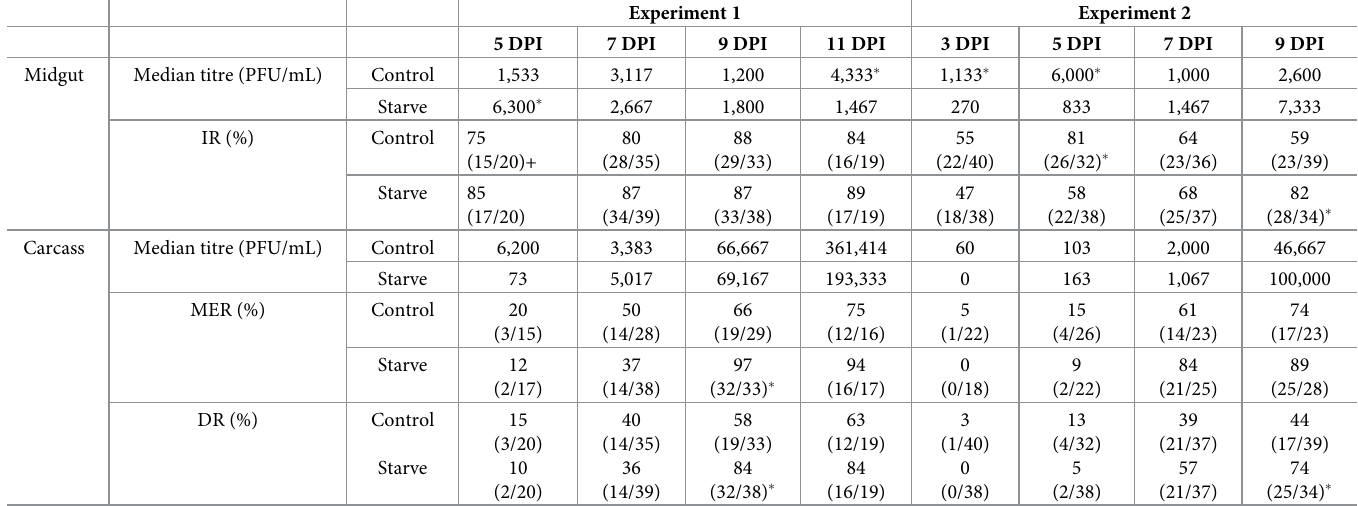
in both treatment groups throughout the time-course; although similar MER were observed in Control and Starve mosquitoes at 5 dpi (20%, 12%, respectively) and 7 dpi (50%, 37%) ( Fig 4A and Table 3 ). By 9 dpi, the MER in Starve mosquitoes (97%) increased significantly compared to Control mosquitoes (66%) ( Fig 4A ; p = 0.001, Fisher’s Exact test), with this trend continuing until 11 dpi (94%, 75%, respectively). Table 3. Median ZIKV titre (plaque forming units per mL), infection rates, and midgut escape rates in Control and Starve midguts and carcasses over a time-course in two independent